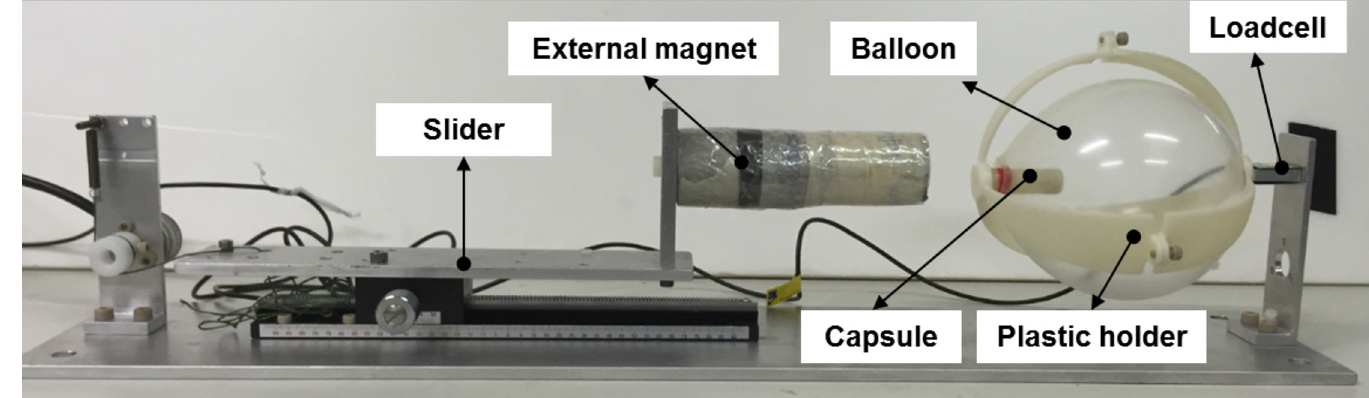
Fig 9. Experiment setup for force measurement.